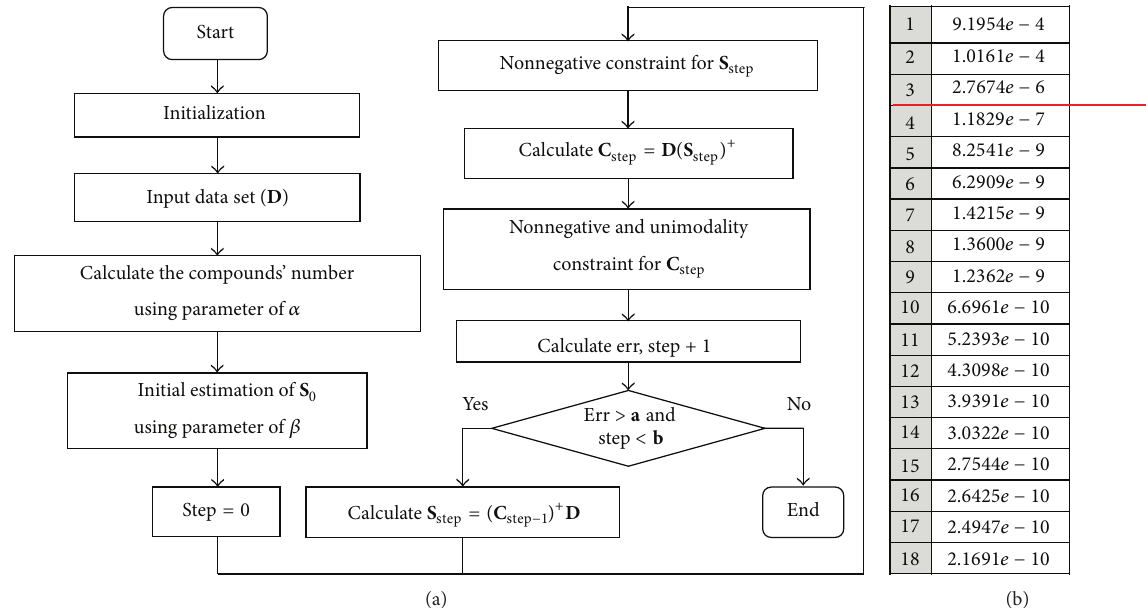
Figure 7: (a) Flowchart of the MCR-ALS method. (b) The singular values for the HPLC-DAD data set ordered from largest to